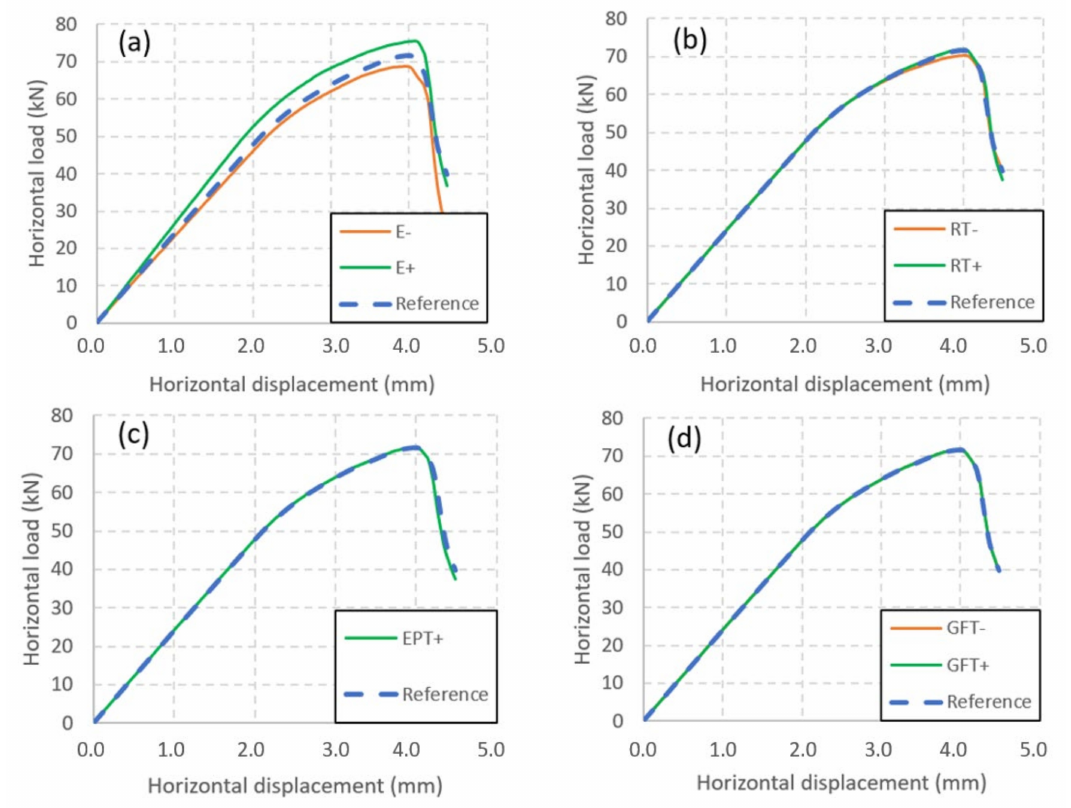
Figure 12. Influence of the coating parameters on the force–displacement curve of the masonry shear wall: ( a ) Young’s modulus; ( b ) tensile strength; ( c ) peak tensile strain; ( d ) fracture energy under